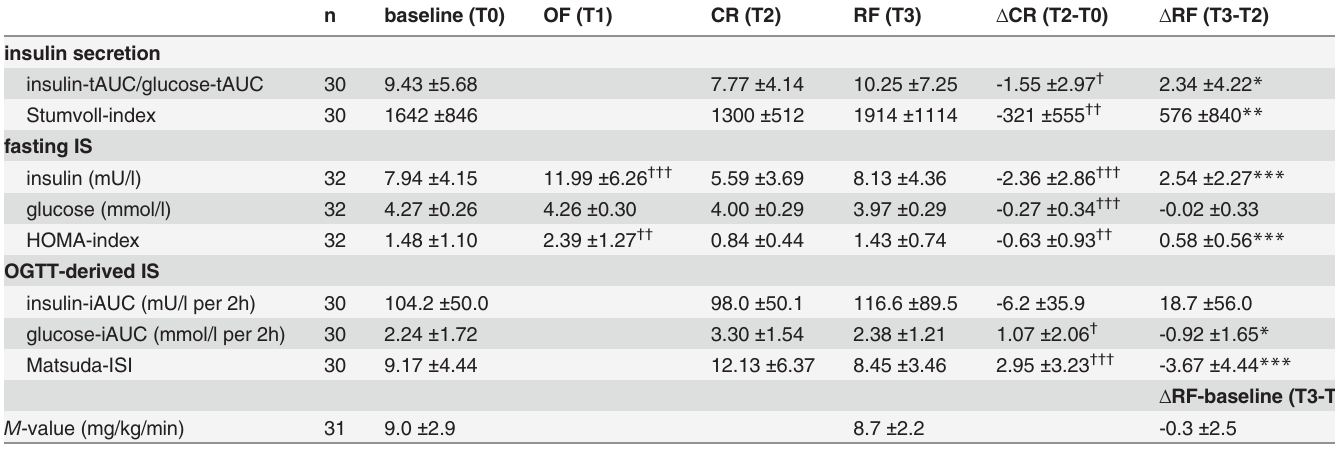
Table 2. Changes in insulin secretion and IS due to overfeeding (OF) caloric restriction (CR) and refeeding (RF) (values are means ± SD).